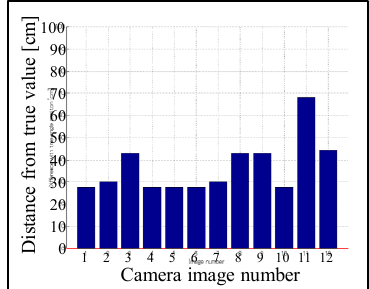
Figure 11. Estimated camera position (wide range)